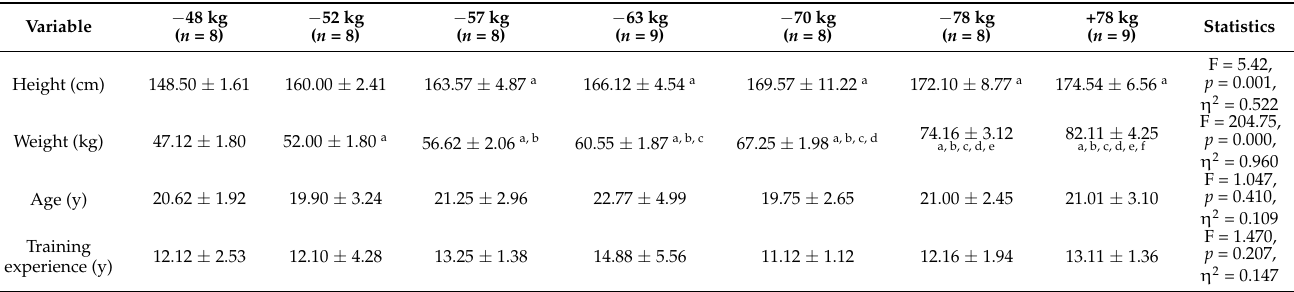
Table 1. Physical characteristics of the